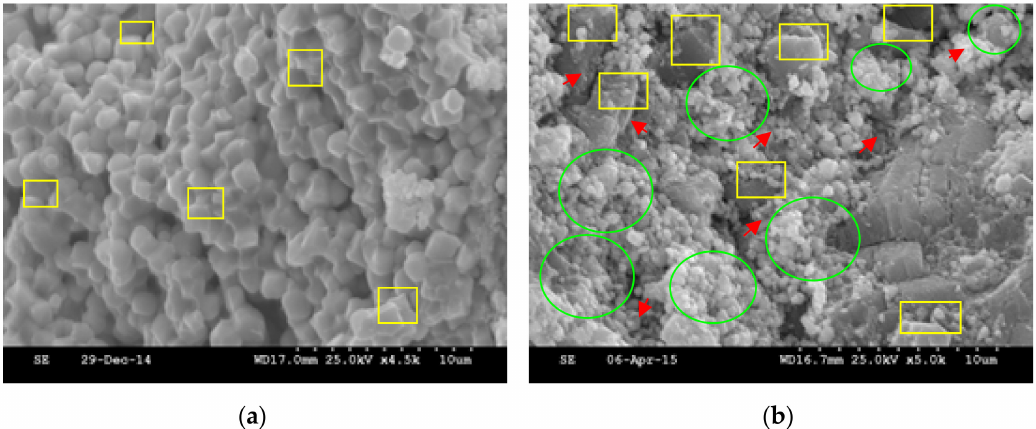
Figure 4. SEM images of PZT and PZTCC composite: ( a ) PZT (yellow rectangle, PZT); ( b ) PZTCC (yellow rectangle, PZT; green ellipse, cement particle; red arrow,